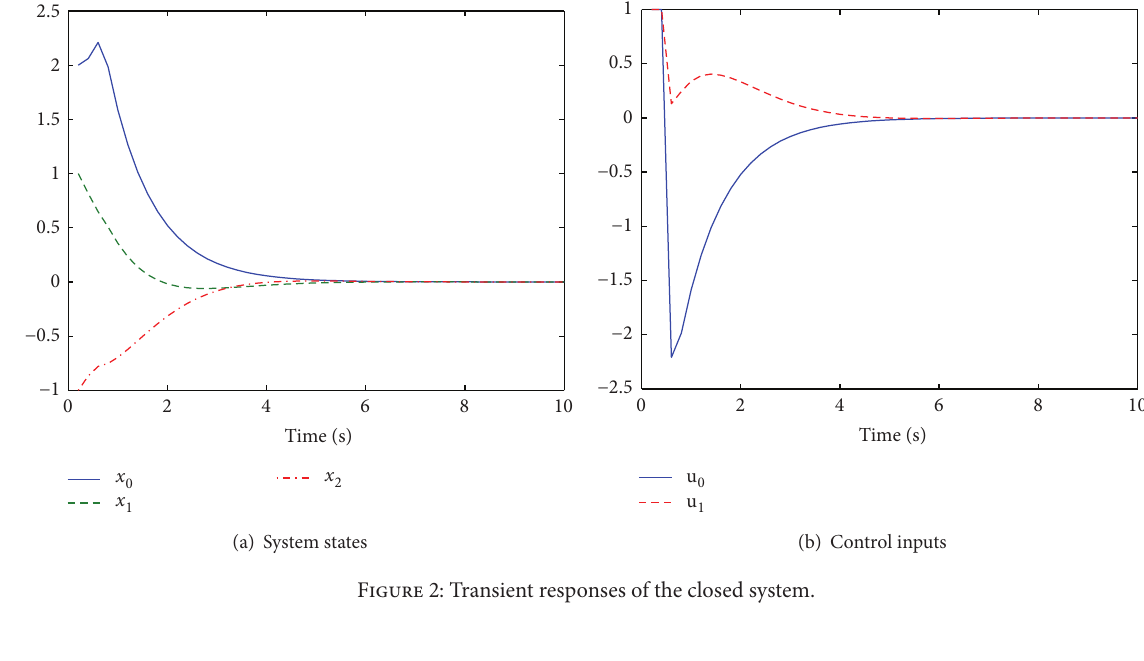
Figure 2: Transient responses of the closed